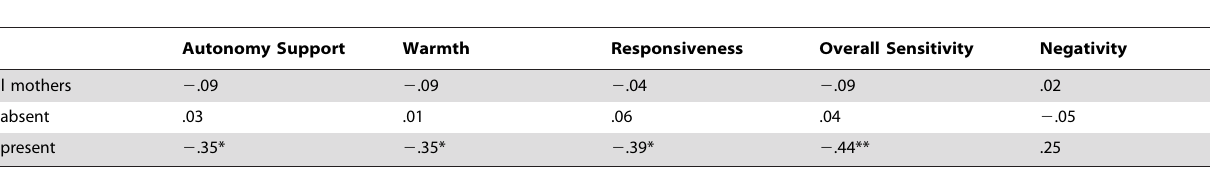
Table 2. Correlations between Risk at Birth and Maternal Behavior as a Function of the Presence/Absence of Maternal DRD4-III 7- Repeat